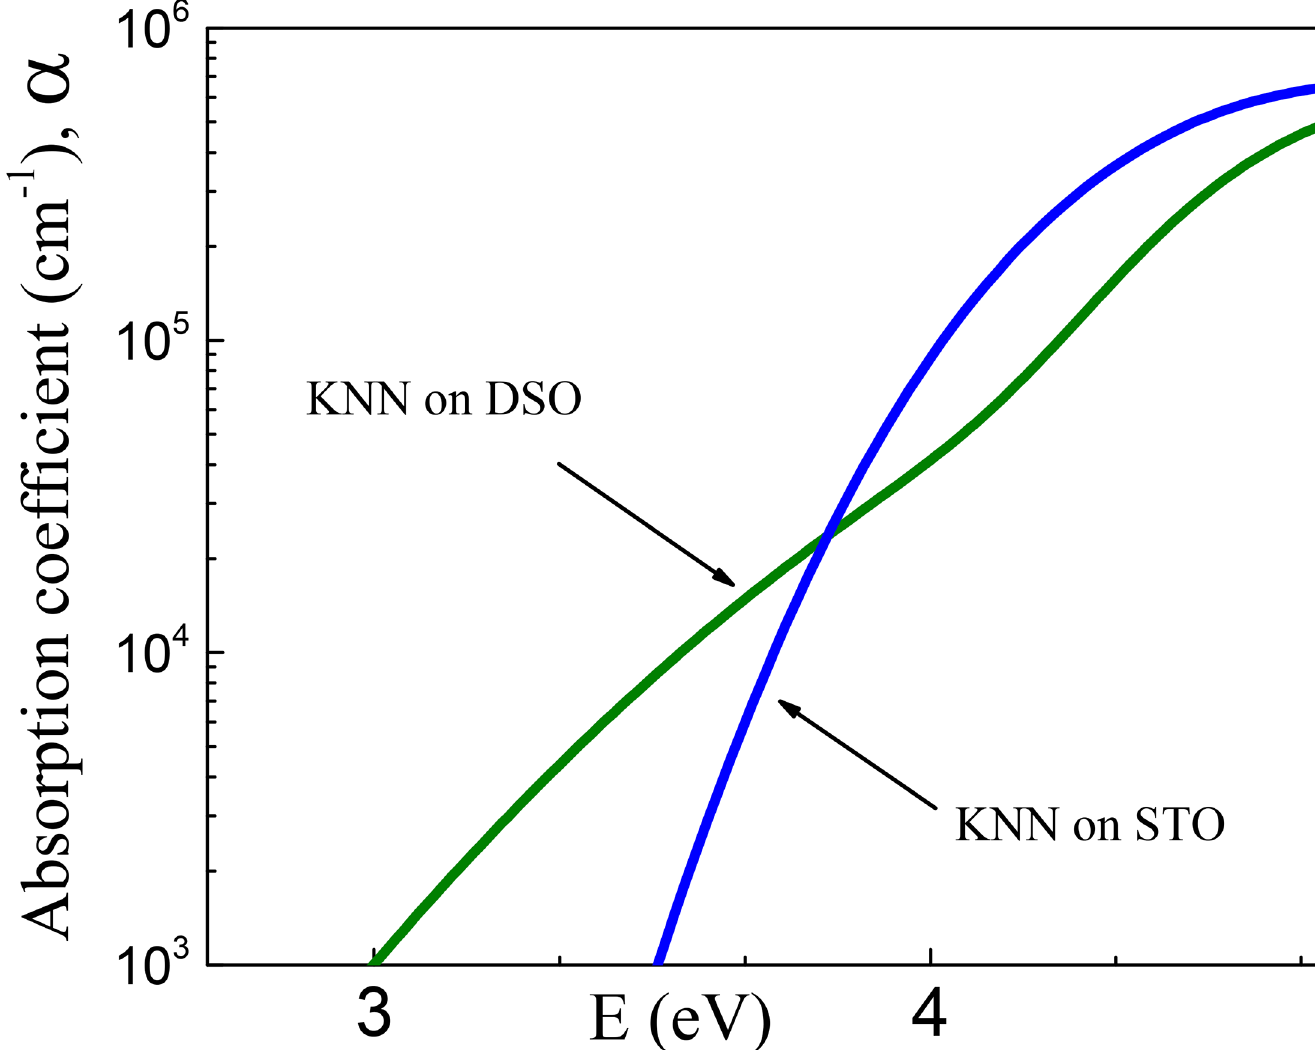
Fig 5. Absorption coefficient α as a function of photon energy E in the KNNO